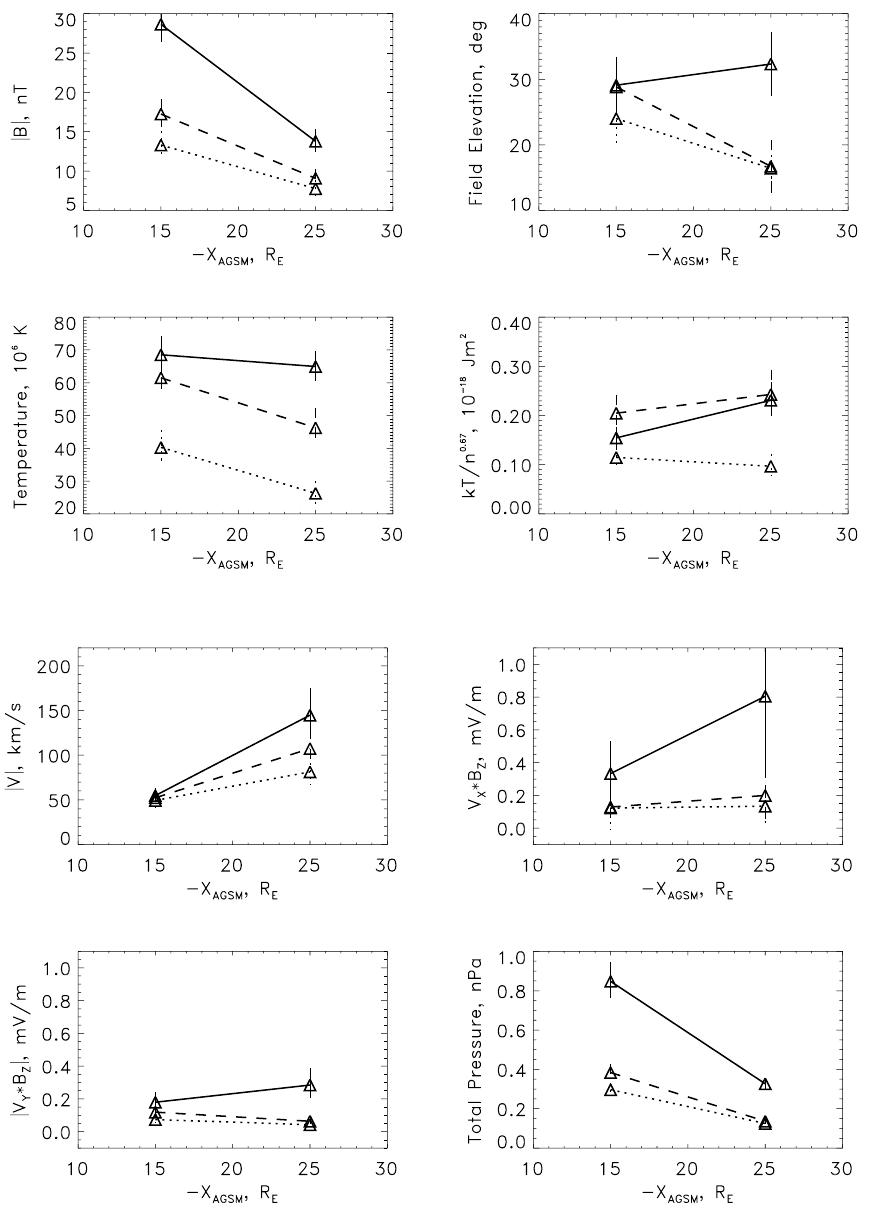
Fig. 2. Average values of the ion bulk velocity, of the rate of earthward trans- port of magnetic flux, V X B Z , of the overall level of east-westward transport of magnetic flux, | V Y B Z | , and of the to- tal pressure in the central plasma sheet. Solid lines: main phase, dashed: recov- ery phase, dotted: quiet times (D st > − 25 ) . Error bars are 0.2 σ of the data distribution